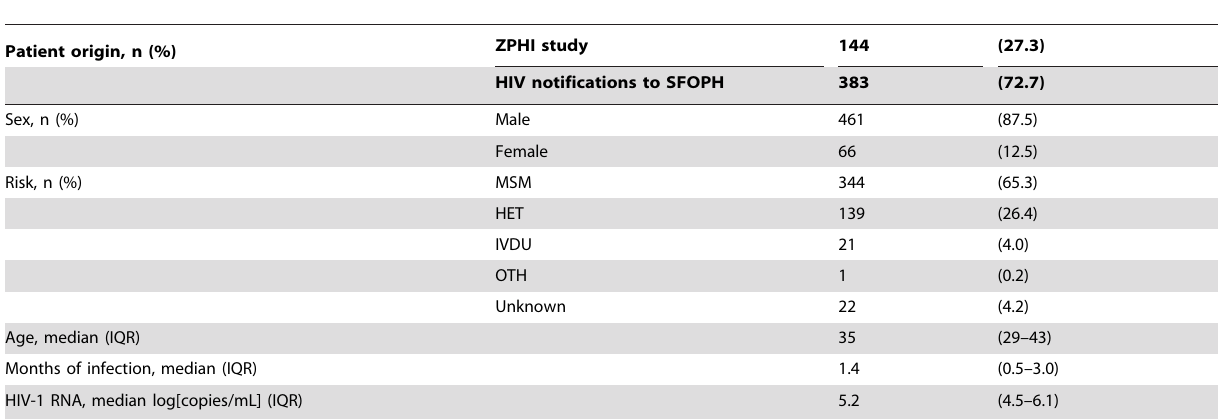
Table 1. Characteristics of the 527 patients with incident HIV-1 infection.